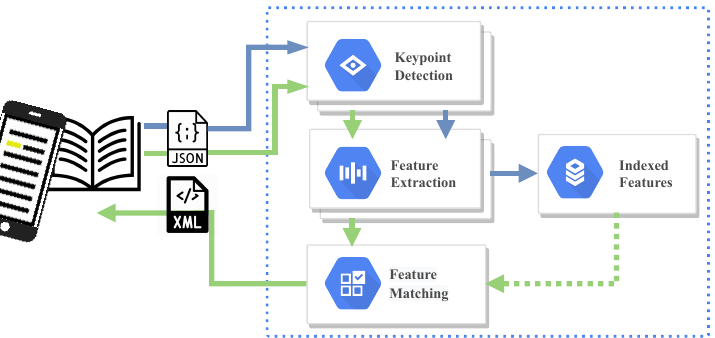
Figure 1. The proposed word spotting client-server pipeline. Blue and green arrows denote the indexing and the query processing sequence,